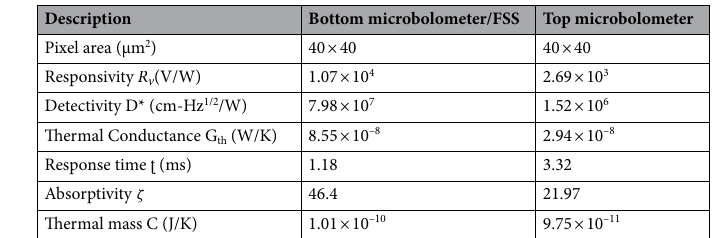
Table 1. Summary of the metasurface enabled microbolometer